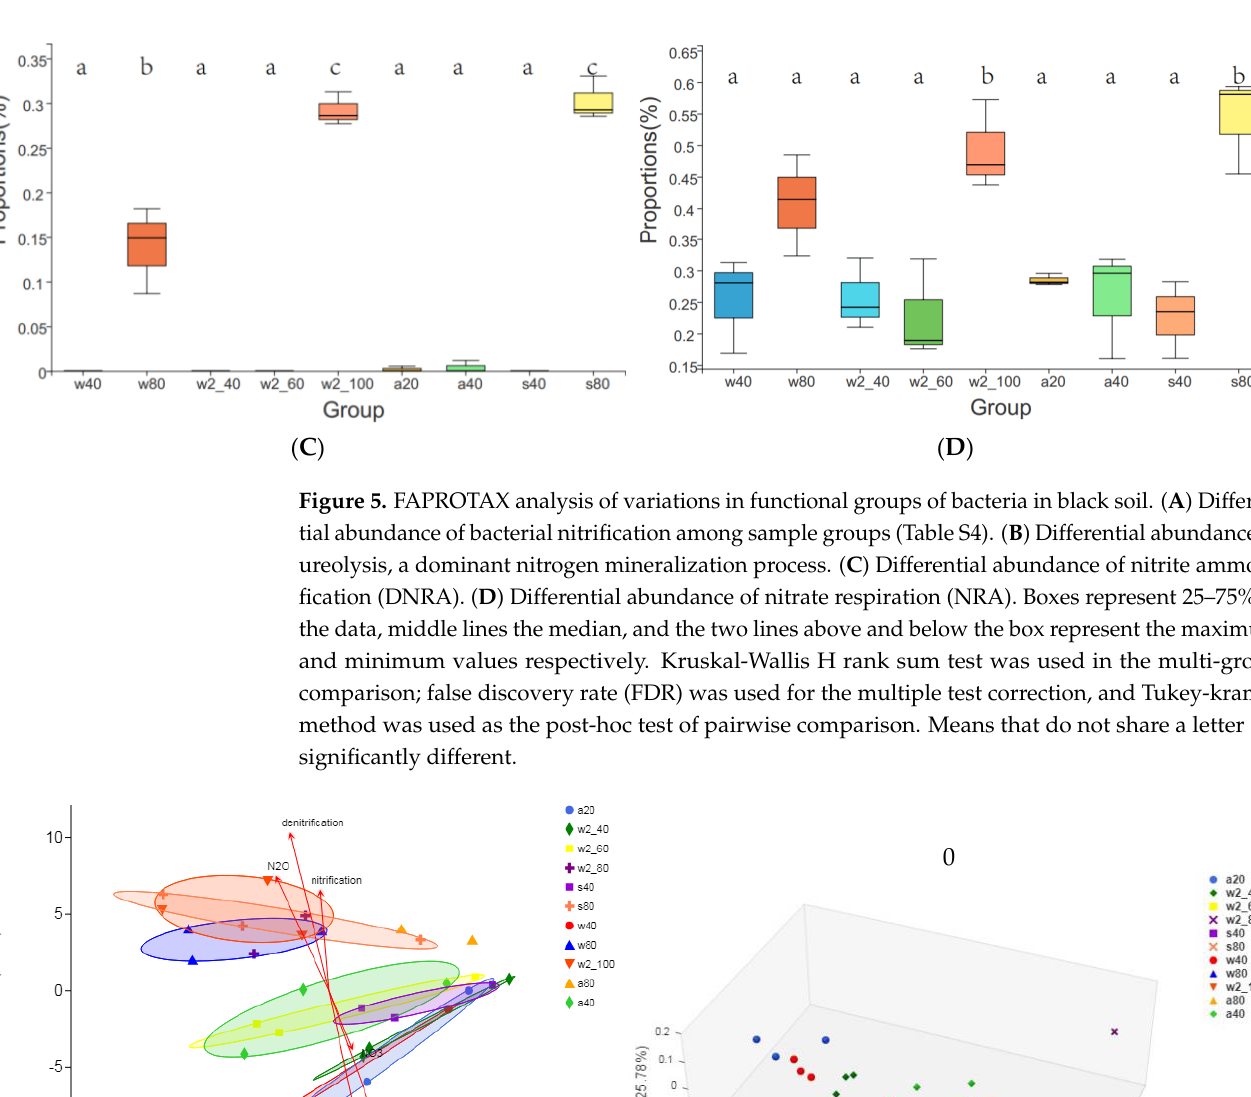
Figure 5. FAPROTAX analysis of variations in functional groups of bacteria in black soil. ( A ) Differ- ential abundance of bacterial nitrification among sample groups (Table S4). ( B ) Differential abun- dance of ureolysis, a dominant nitrogen mineralization process. ( C ) Differential abundance of nitrite ammonification (DNRA). ( D ) Differential abundance of nitrate respiration (NRA). Boxes represent 25 – 75% of the data, middle lines the median, and the two lines above and below the box represent the maximum and minimum values respectively. Kruskal-Wallis H rank sum test was used in the multi-group comparison; false discovery rate (FDR) was used for the multiple test correction, and Tukey-kramer method was used as the post-hoc test of pairwise comparison. Means that do not share a letter are significantly different.